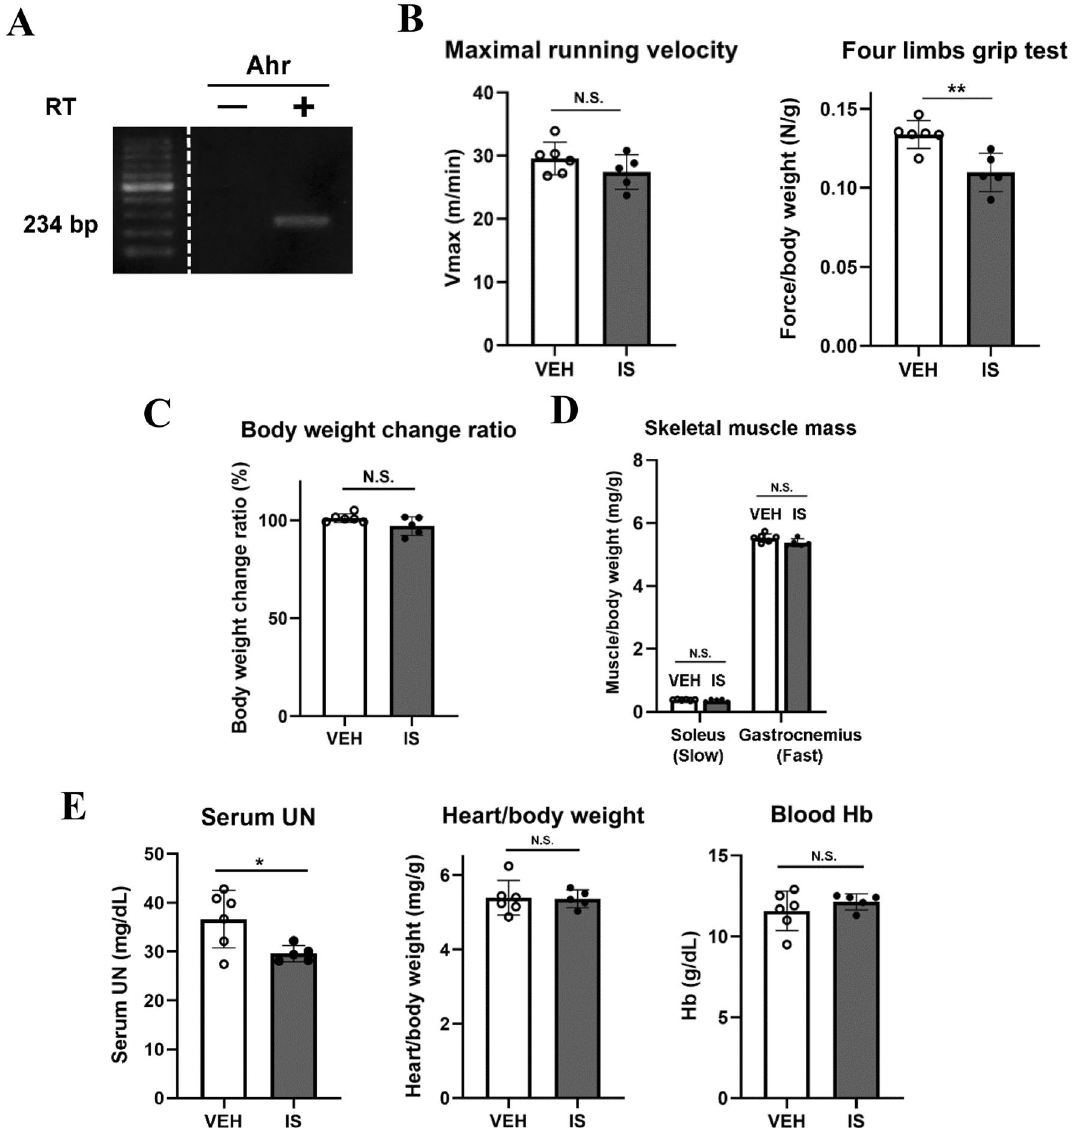
Figure 1. IS administration caused skeletal muscle weakness and a tendency toward muscle atrophy in mice after unilateral-nephrectomy. ( A ) Expression of the endogenous receptor of indoxyl sulfate (IS) and the aryl hydrocarbon receptor (Ahr) was confirmed with electropheresis for PCR products of mouse gastrocnemius (GC) muscle cDNA. PCR products without reverse transcriptase (RT) were loaded as negative controls. The figure was cropped to show regions of interest. Full-length of the gel is shown in the supplementary Fig. 1. ( B ) Maximal running velocities (Vmax) measured in a treadmill running exhaustion test (left) and grip strengths from the four limbs grip test (right) are shown. Mice underwent unilateal nephrectomies one week prior to treatment with vehicle (VEH) or IS for 7 days. ( C ) Body weight change ratios before and after 7 days of treatment, and ( D ) skeletal muscle wet weight/body weight of soleus and GC muscles after one week of treatment are shown. ( E ) Serum urea nitrogen (UN, left), heart/body weight (middle), and blood hemoglobin (Hb, right) after one week of treatment are shown. N = 5–6 mice per group. Error bars denote SEM. * p < 0.05, ** p < 0.01, N.S.; no significance, bp; base